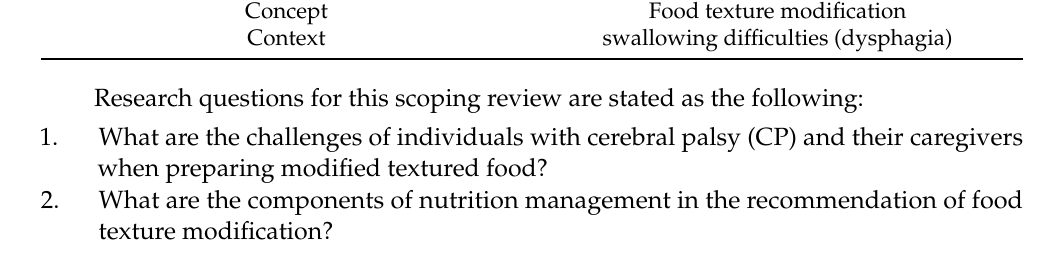
Table 2. List of keywords and synonyms generated as search